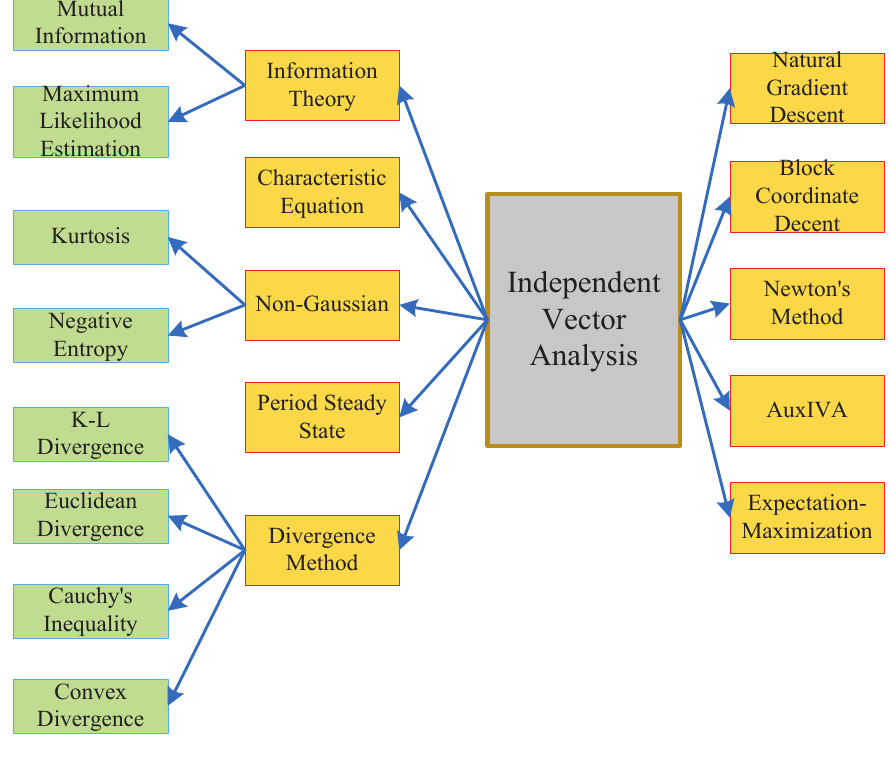
Figure 5. Basic components of